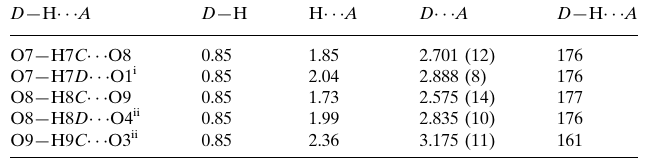
Hydrogen-bond geometry (A˚ , (cid:4)